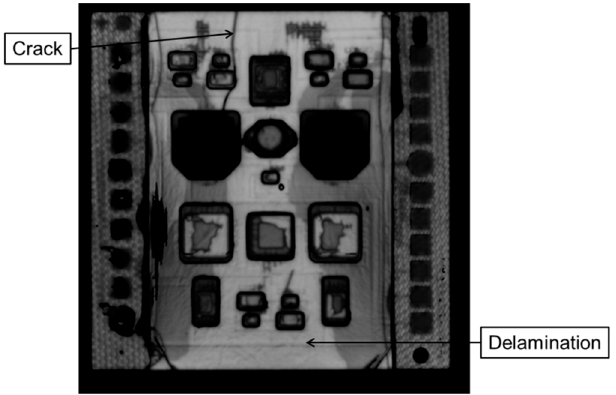
Figure 7. Image from scanning acoustic microscopy showing widespread delamination after long term thermal cyclic loading.